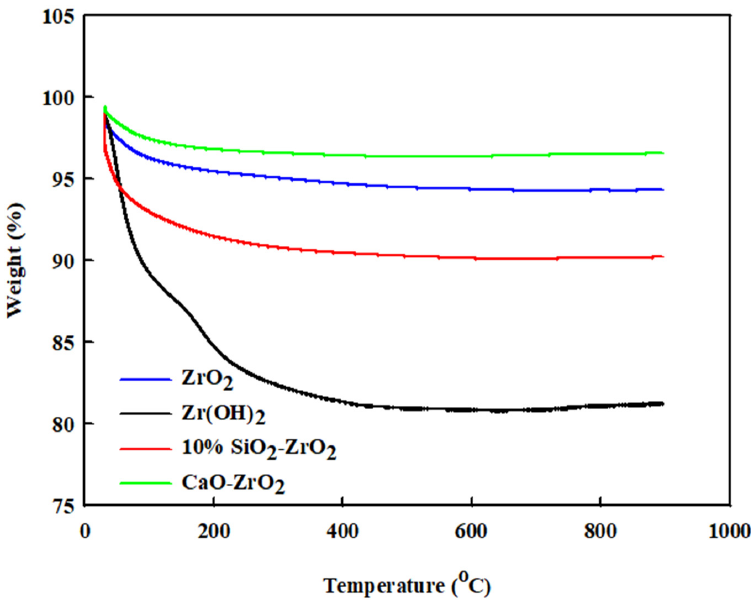
Figure 4. TGA-profile analysis for ZrO 2 , Zr(OH) 2 , CaO-ZrO 2 and 10% SiO 2 -ZrO 2 .